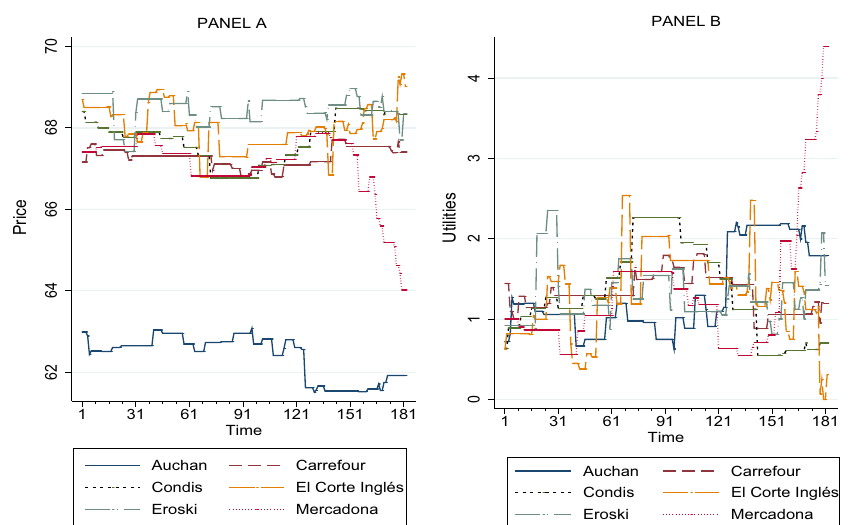
Fig. 2 Ranking over time, by price and estimated utility (Barcelona)